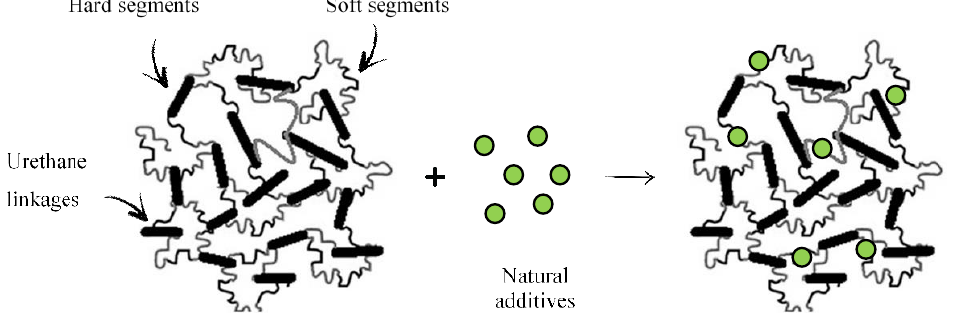
Figure 1. The impact of the natural additives’ addition on the crosslinking density of PUR composites. Adapted from Ref. [14].